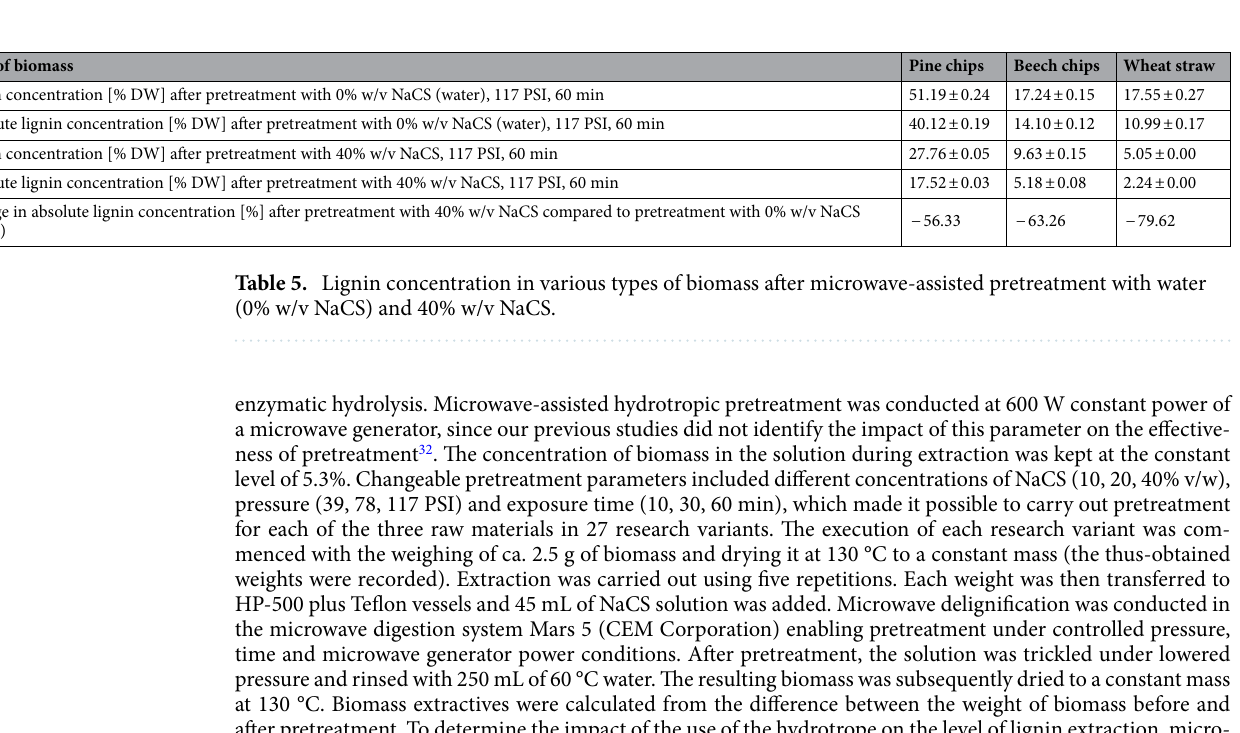
Type of biomass Pine chips Beech chips Wheat